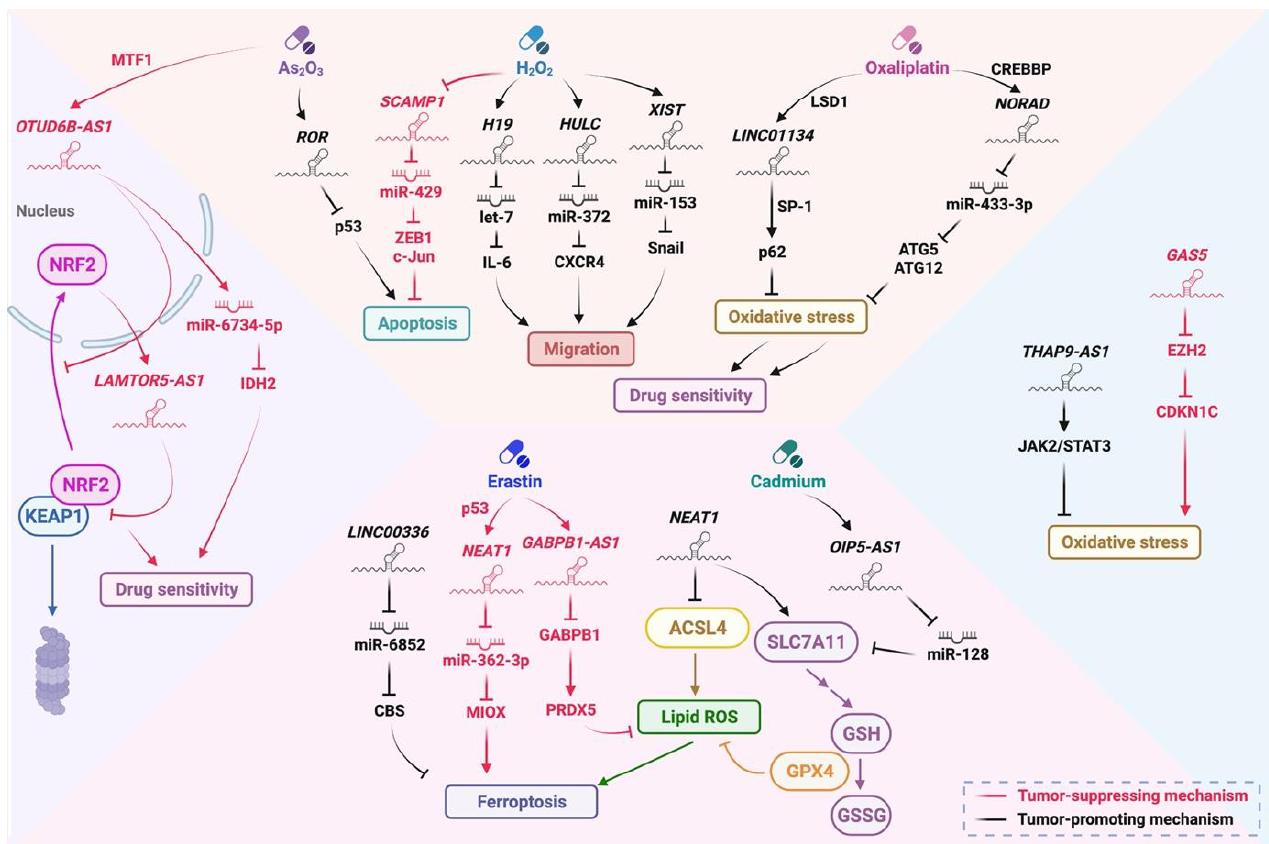
Figure 3. LncRNAs participate in the regulation of oxidative stress response in multiple aspects. LncRNAs such as OTUD6B-AS1 and LAMTOR5-AS1 regulate the function of NRF2 and further affect drug sensitivity. GAS5 and THAP9-AS1 are reported to induce and reduce oxidative stress, respectively. On the other hand, lncRNAs are demonstrated to be modulated by oxidative stress-inducing chemotherapeutic agents, including As 2 O 3 , H 2 O 2 , oxaliplatin, erastin and cadmium, to manage therapeutic efficacy through a series of biological processes, such as apoptosis, migration and ferroptosis. NRF2 (nuclear factor erythroid 2-related factor 2), KEAP1 (kelch-like ECH-associated protein 1), MTF1 (metal regulatory transcription factor 1), IDH2 (isocitrate dehydrogenase 2), ZEB1 (zinc finger E-box binding homeobox 1), IL-6 (interleukin 6), CXCR4 (C-X-C motif chemokine receptor 4), LSD1 (Lysine-specific demethylase 1), SP-1 (specificity protein 1), CREBBP (CREB binding protein), ATG5 (autophagy related 5), ATG12 (autophagy related 12), JAK2 (janus kinase 2), STAT3 (signal transducer and activator of transcription 3), EZH2 (enhancer of zeste homolog 2), CDKN1C (cyclin dependent kinase inhibitor 1C), CBS (cystathionine beta-synthase), MIOX (myo-inositol oxygenase), GABPB1 (GA binding protein transcription factor subunit beta 1), PRDX5 (peroxiredoxin 5), ACSL4 (acyl-CoA synthetase long chain family member 4), SLC7A11 (solute carrier family 7 member 11), GSH (glutathione), GSSG (glutathione disulfide) and GPX4 (glutathione peroxidase 4). This figure was created with